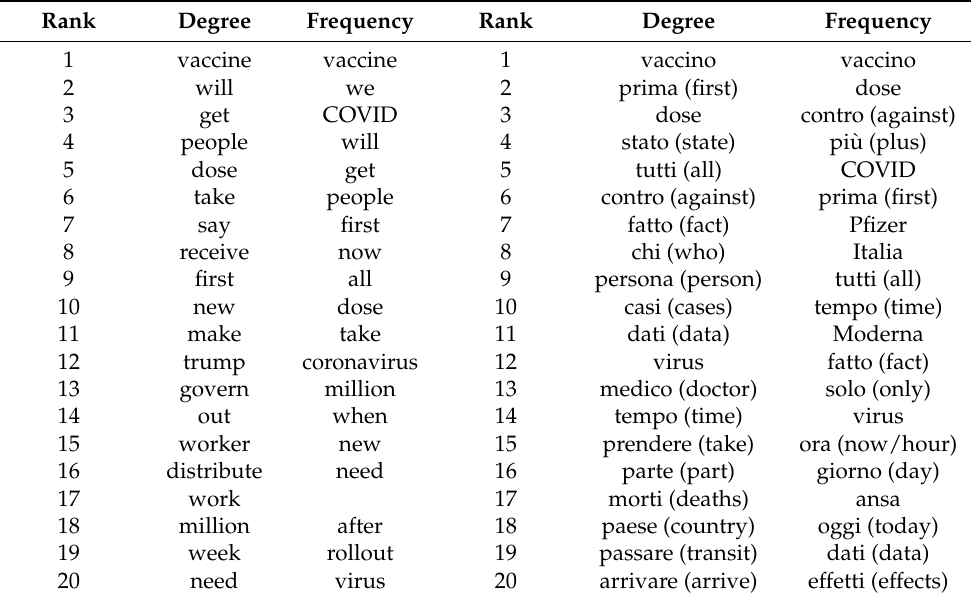
Table 1. Top-20 key concepts in the English (left) and Italian (right) corpora. Words are ranked according to their degree in textual forma mentis networks and their frequency in the original tweets. Italian words were translated into English for easier